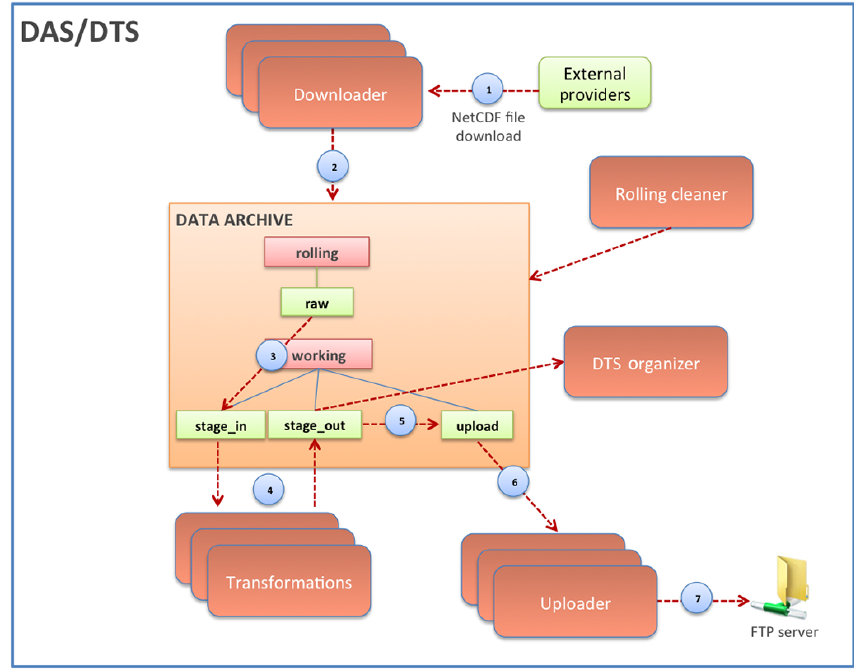
Figure 3. Interactions between the DAS, the DTS and the data archive.